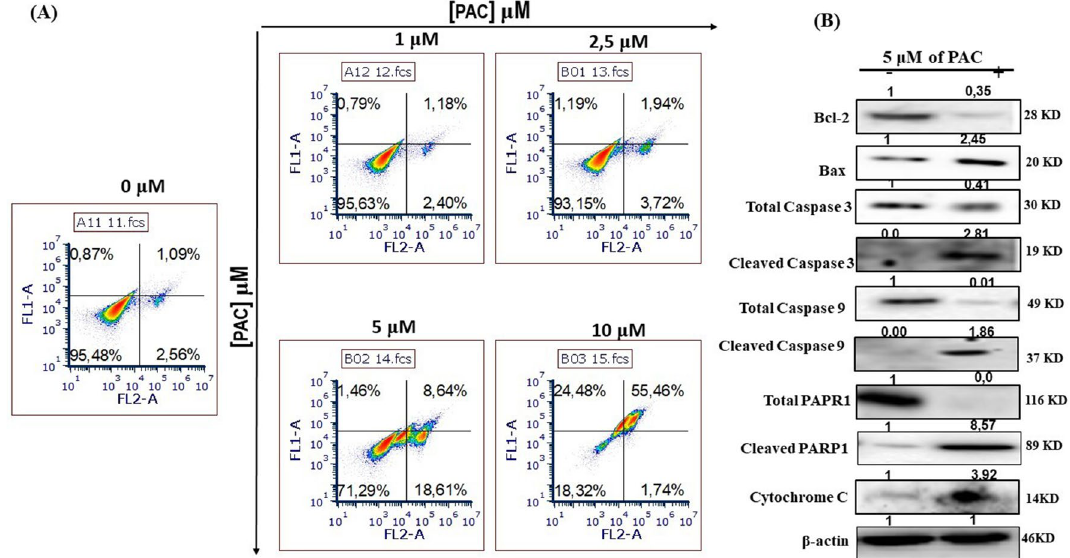
Figure 4. PAC induces apoptosis in oral cancer cells by targeting the intrinsic mitochondrial pathway. ( A ) Fluorochrome-labeled annexin V with PI assay; stained cells were subjected to flow cytometry analyses, using a “LSRII” or “CantoII ” cytometer instrument from BD Biosciences (n = 5). ( B ) PAC dose—dependant increased apoptosis by activation of caspases in Ca9-22 cells (n = 5). ( C ) The effect of PAC of caspase signaling for oral cancer cell apoptosis was confirmed by Western blotting. PAC at 5 µM strongly decreases Bcl-2 expression and increases that of pro-apoptotic Bax and cytochrome C as well as allows cleavage of PARP-1. The effect of PAC promoting cancer cell death involves caspase-3/9 (n = 3). All Blots for each apoptosis protein derive from the same experiment and were exposed at same time of phosphor imager